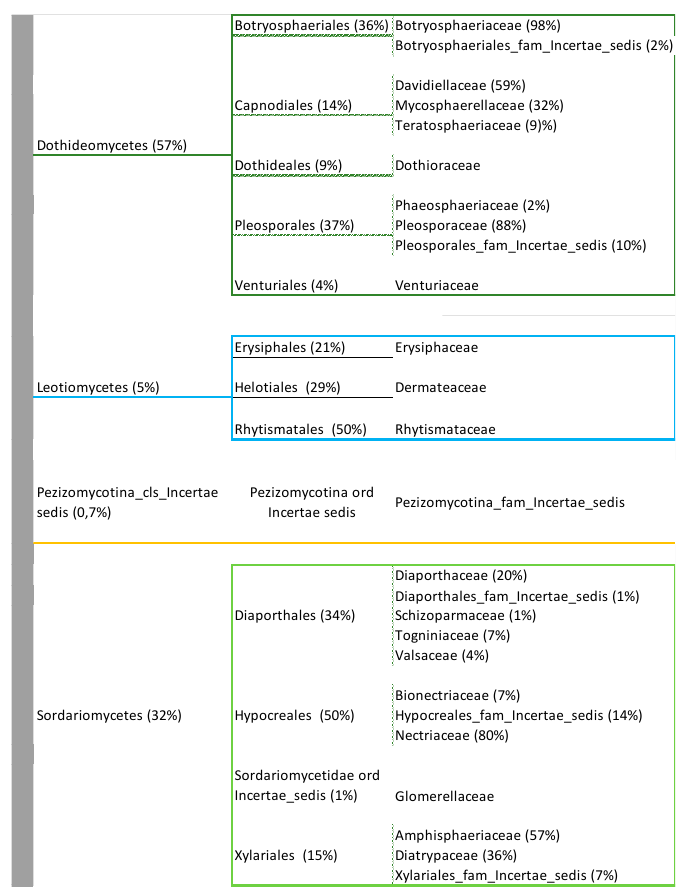
Figure 2. Relative abundance of fungi in seed assigned to different trophic levels in FUNGuild.